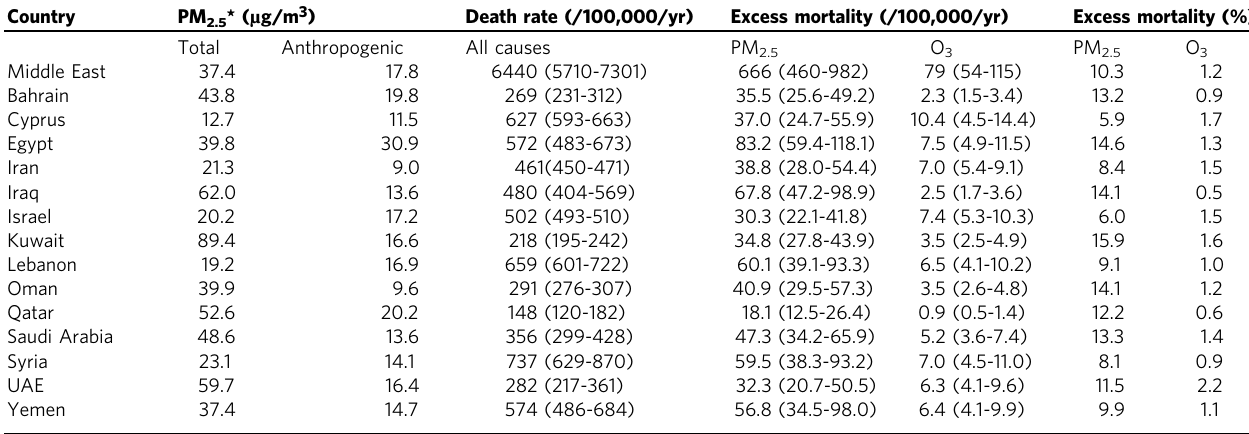
Table 1 Annual mean exposure, total death rate and excess mortality (with the 95% con fi dence intervals in parentheses).